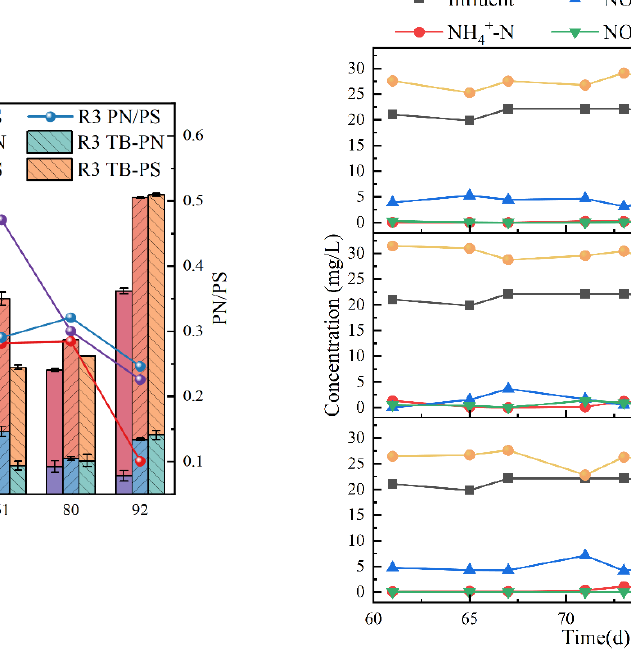
Figure 5. ( A ) PN, PS, and PN/PS contents of R1, R2, and R3; the concentrations of NH 4+ -N, NO 3 − -N, NO 2 − -N, and TIN removal of R1 ( B ), R2 ( C ), and R3 ( D ).